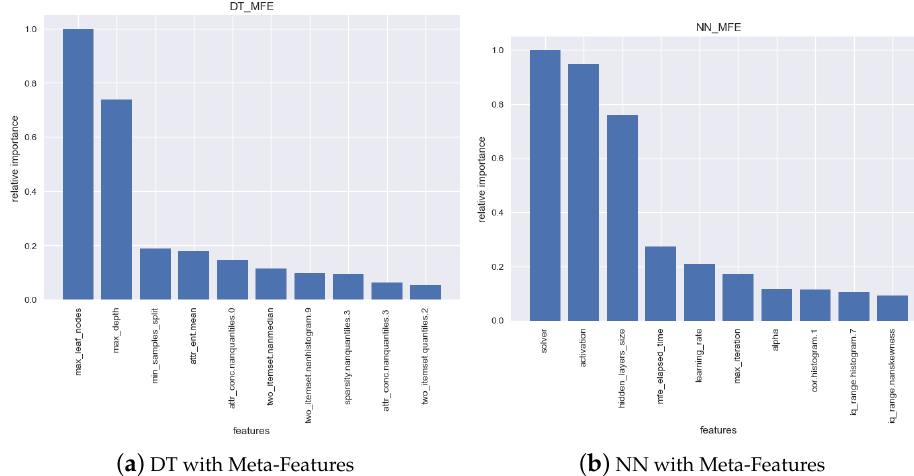
Figure 5. Relative importance of the 10 most relevant features for each